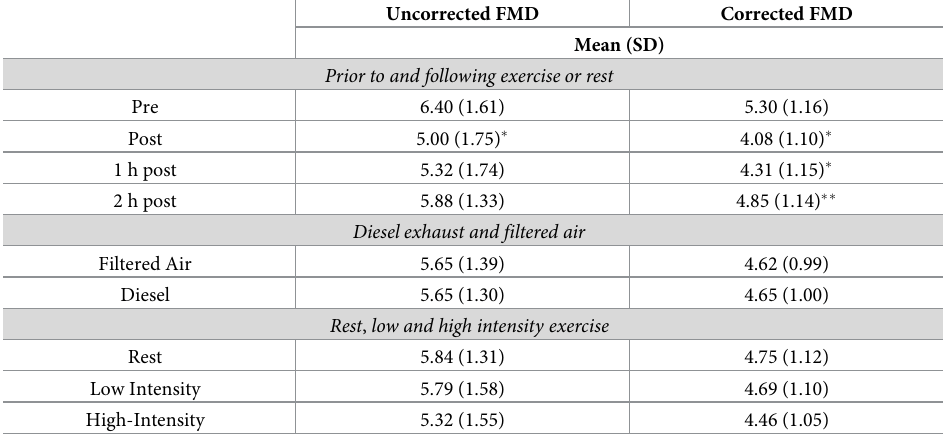
Table 1. The main effects of time, exposure condition and intensity on FMD (Mean (SD)) in 17 recreationally active